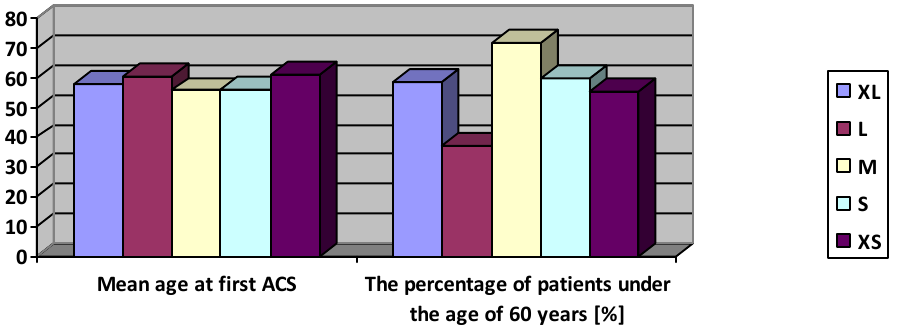
Figure 2. The comparison of mean age and the percentage of patients at the age under 60 years during first acute coronary syndrome depending on the combination of genetic